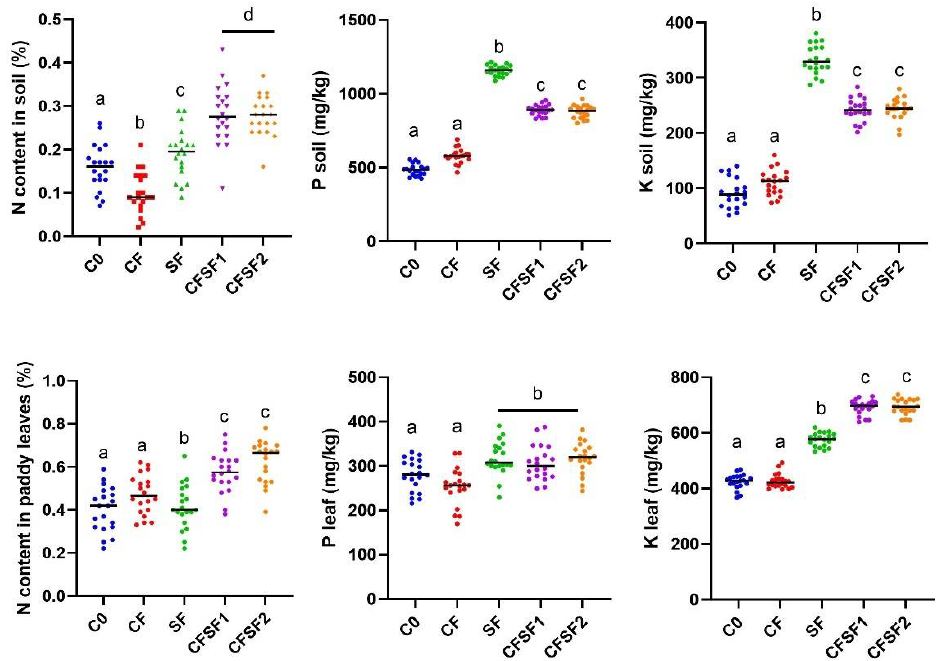
Figure 2. The effects of SF on macronutrient nitrogen (N), phosphorus (P), and potassium (K) in soil and paddy plant leaves after harvest. Different annotation letters indicate significant difference ( p < 0.01) between groups.